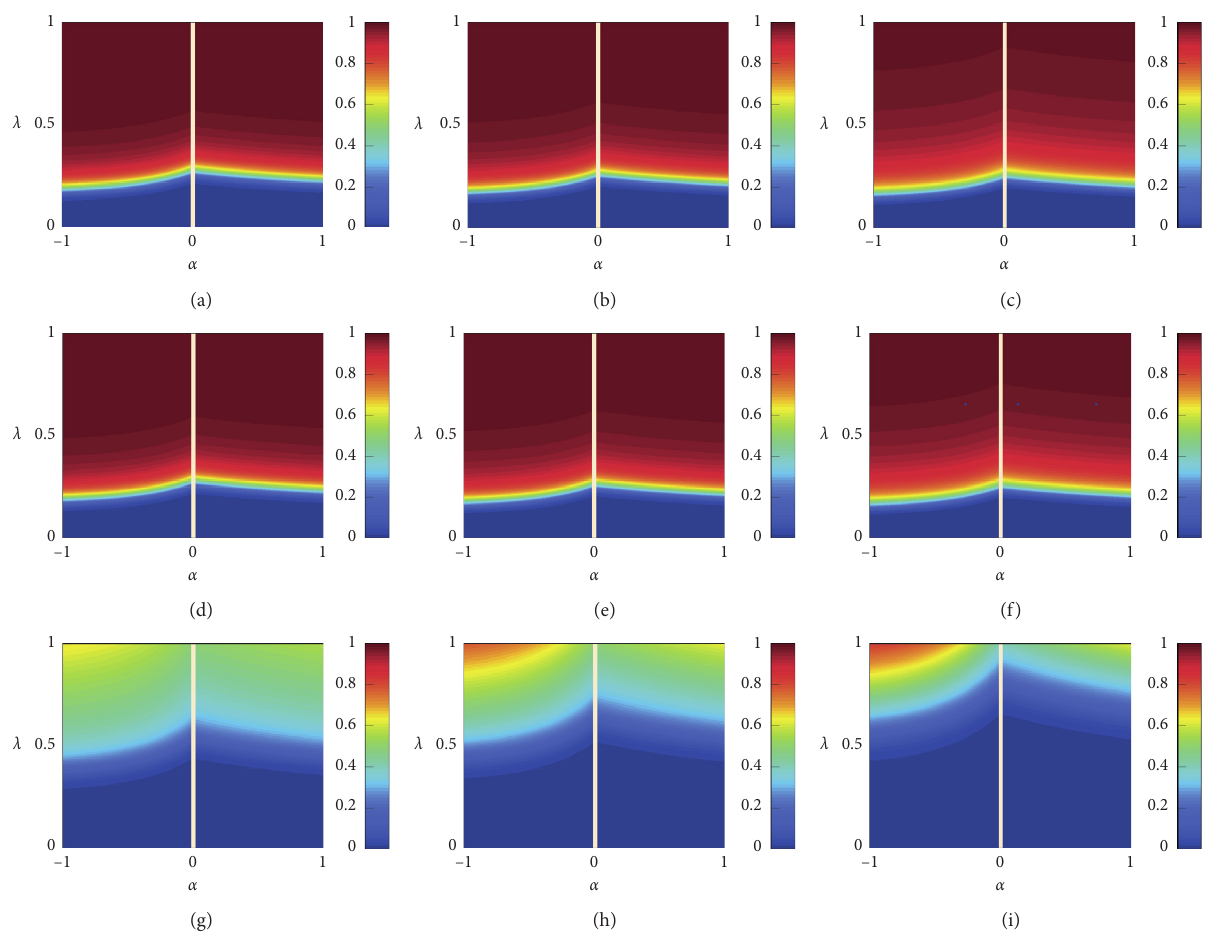
Figure 2: Phase diagram on parameter space ( α , λ ) on the ER network with β � − 1 (a) (d) (g), β � 0 (b) (e) (h), and β � 1 (c) (f) (i). (a)–(c) ( f � 0 . 03), (d)–(f) ( f � 0 . 05), and (g)–(i) ( f � 0 . 1). The color represents the theoretical value of the outbreak size R ( ∞ ) . The white dotted � line in each subgraph indicates the optimal value of α opt